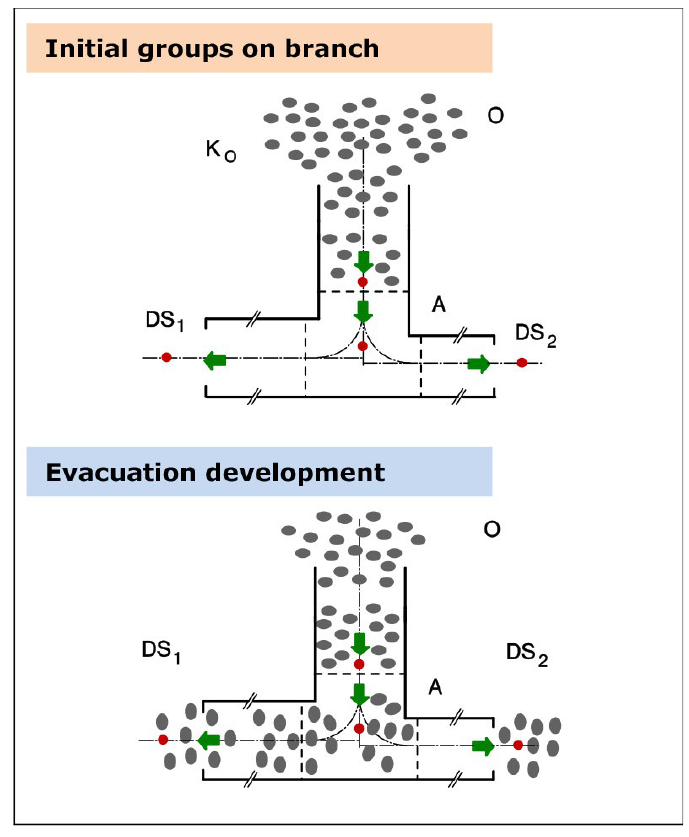
Figure 21. Existence of groups in a branch